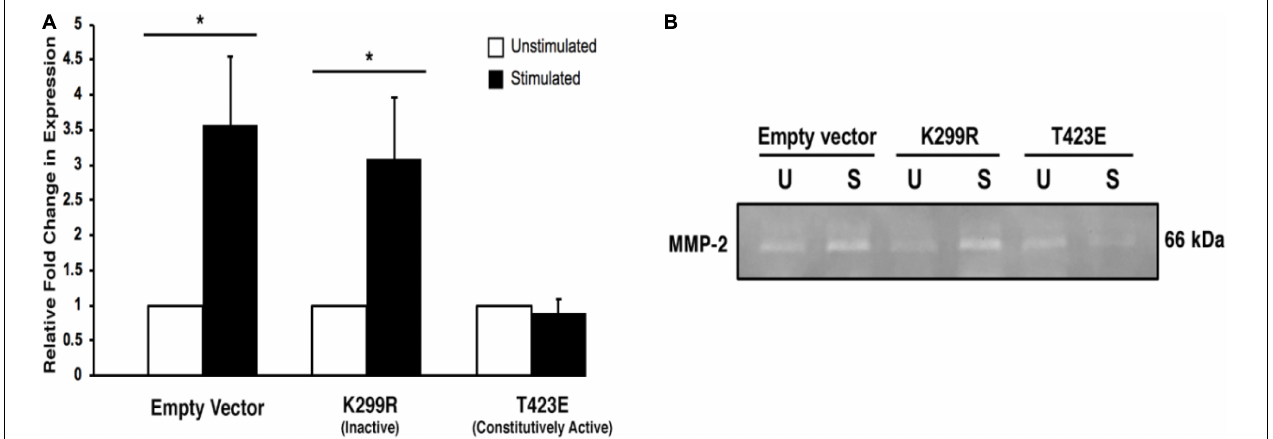
FIGURE 7 | Overexpression of the kinase-dead mutatnt PAK1leads to more active MMP-2-mediated degradation. (A) When PAK1 (K299R) is transiently overexpressed, there is a significantly greater gelatin degradation with mechanical stimulation. However, when the constitutively active PAK1 is overexpressed